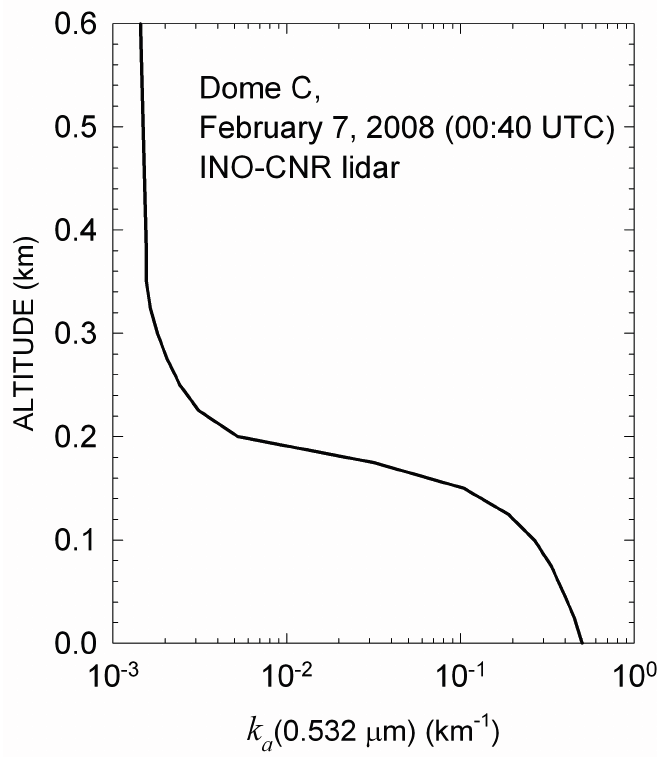
Figure 4. Vertical profile of volume aerosol extinction coefficient k a ( 0.532  m ) obtained from the INO-CNR lidar measurements conducted at Dome C on 7 February 2008 (00:40 UTC). The relatively large values of the measured backscattering coefficient B bs ( 0.532  m ) close to the ground is due to wind-mobilized diamond dust particles. The corresponding visual range V 0 is 7.7 km and the overall value of the aerosol optical thickness τ a ( 0.55  m ) is